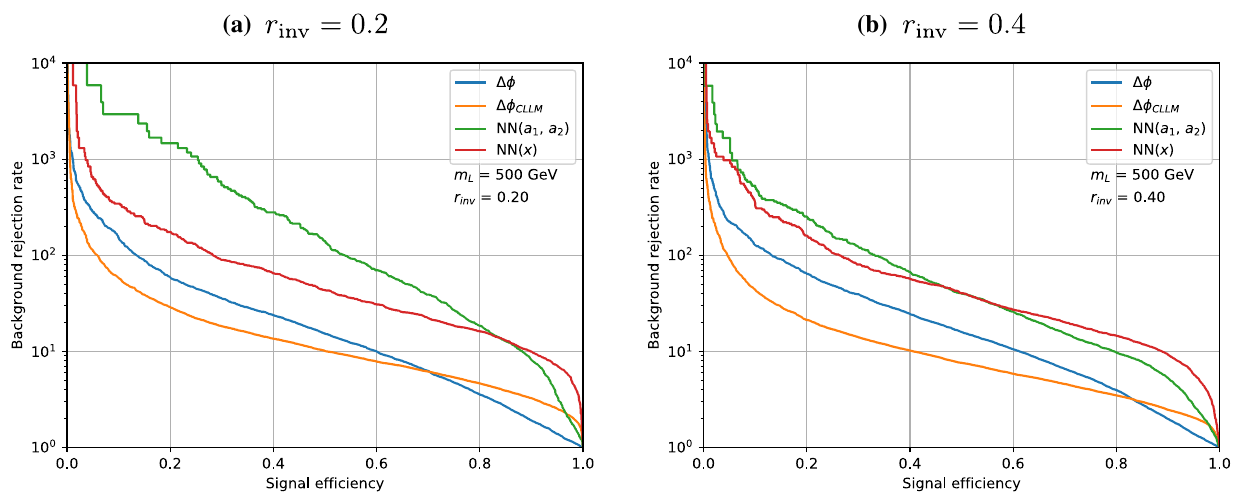
Fig. 50 ROC curves for (cid:7)φ (blue), (cid:7)φ CLLM (orange) and for the neural networks using the input variables a 1 and a 2 (green) or the set x (red) for a mediator mass (here called L ) of 500 GeV. Taken from Ref. [215] Table 5 Settings of the pythia Hidden Valley module used for generating the dark shower signal in Ref. [73]